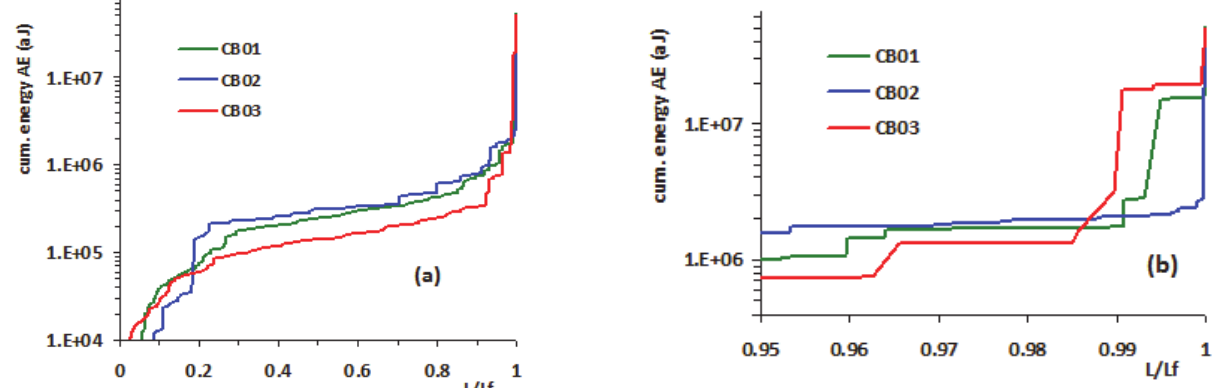
Figure 6: (a) The cumulative AE energy vs. normalized load (L/L f ) for the three experiments and (b) a detailed view close to the fracture